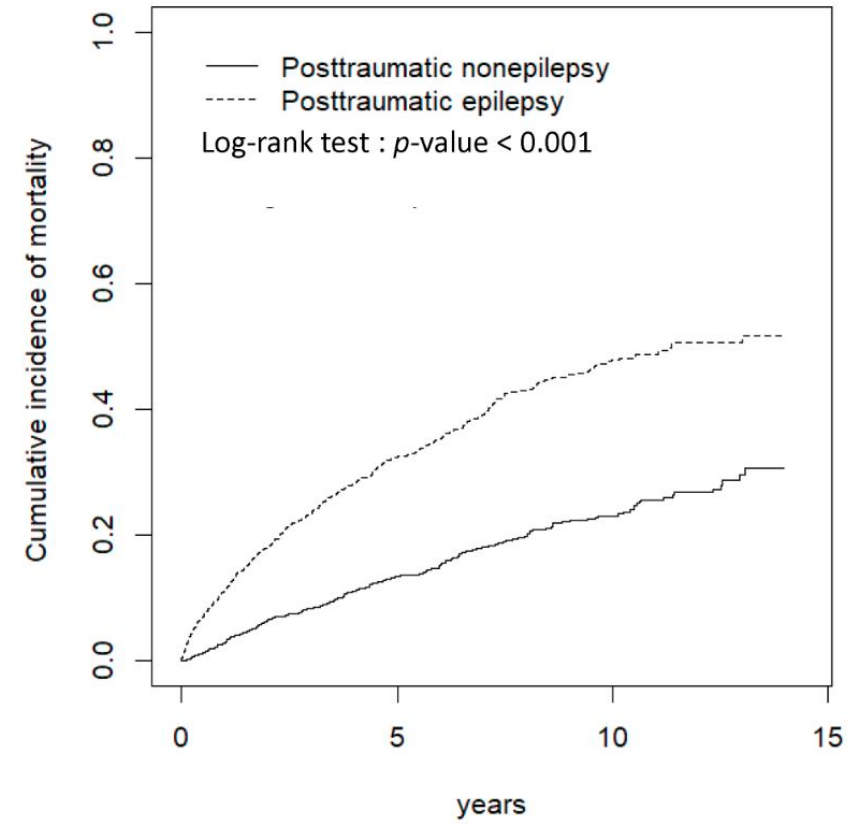
Figure 1. Cumulative incidence of mortality between patients with and without posttraumatic epilepsy after traumatic brain injury.